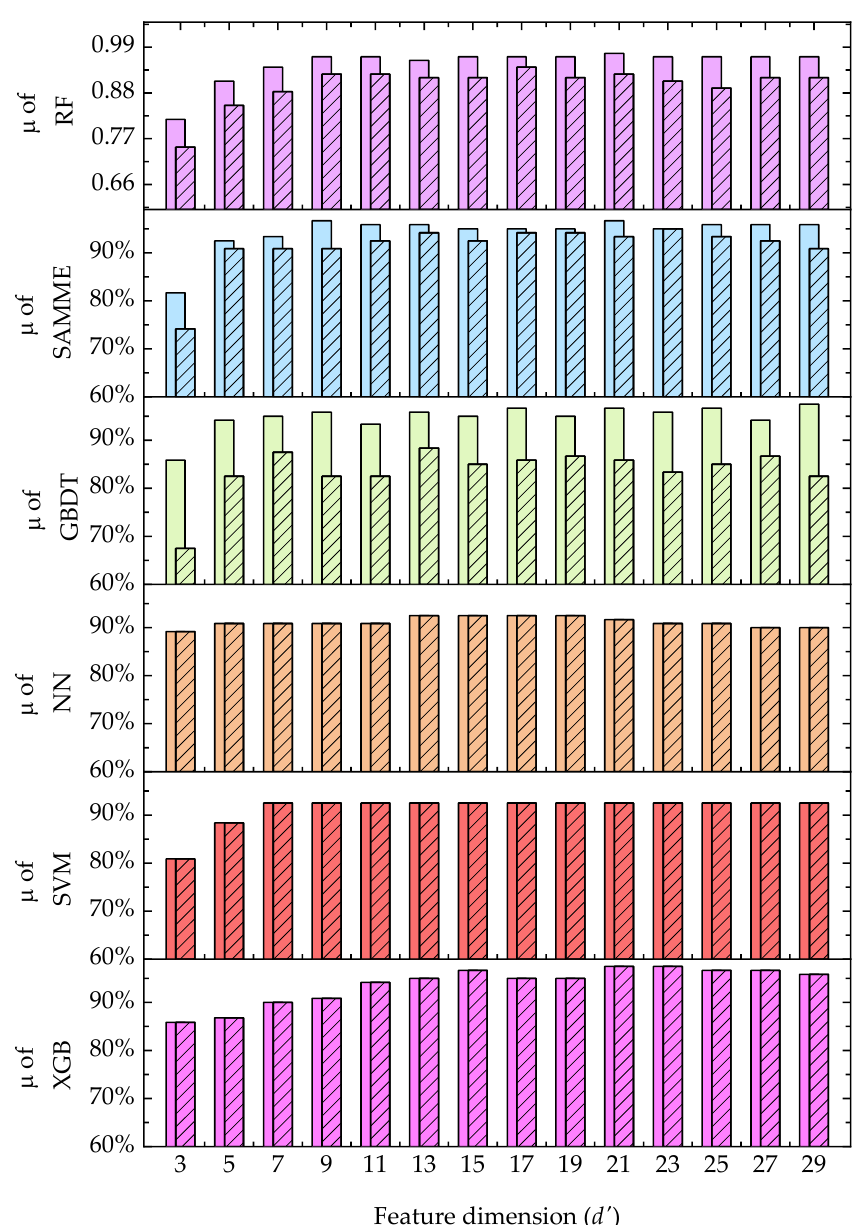
Figure 5. The mean identification accuracies µ obtained by the six tested classification methods when the output feature dimension of PCA is set as different numbers. Bars with and without shading pattern indicate the mean accuracies obtained with the test and training sets, respectively.